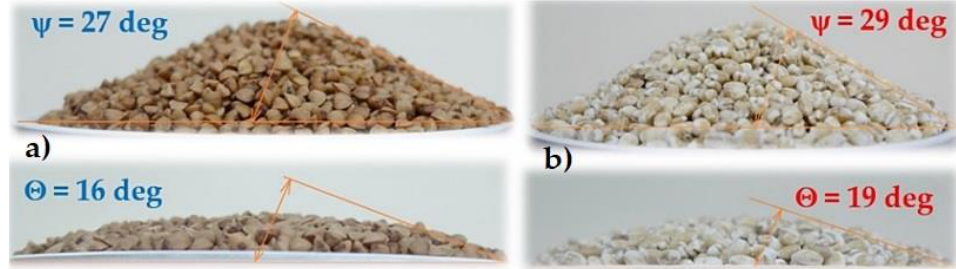
Figure 4. Angles of repose of the transported material ( a ) chickpeas, ( b ) barley